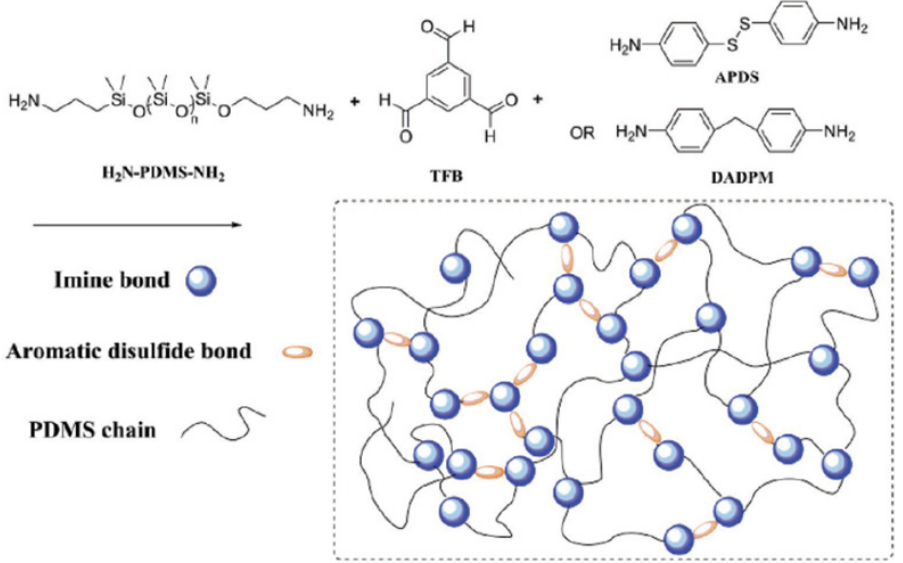
Figure 33. Dual imine- and disulfide-functionalized PDMS elastomers synthesized from aminopropyl poly(dimethyl siloxane), 1,3,5-triformyl benzene (TFB), and either 4-aminophenyl disulfide (APDS) or 4,4 ′ -aminophenyl methane (DADPM). Reaction with APDS resulted in a dual-functionalized network, whereas reaction with DADPM resulted in a mono-functionalized imine network. Reprinted with permission from [17]. Copyright (2017) Wiley Periodicals, Inc.